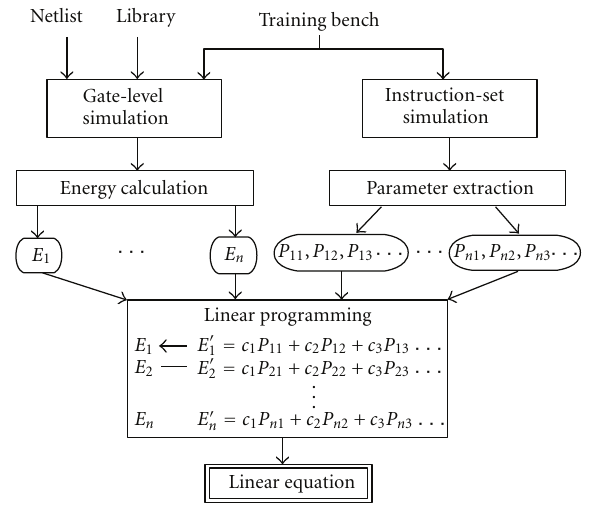
Figure 2: Overview of energy characterization.